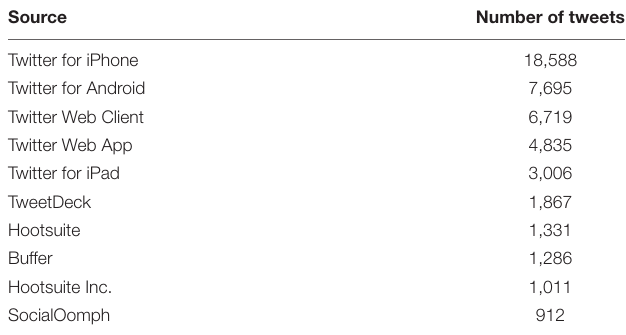
FIGURE 2 | Comparison of likes and hashtags of tweets on SRL (2011–2021).